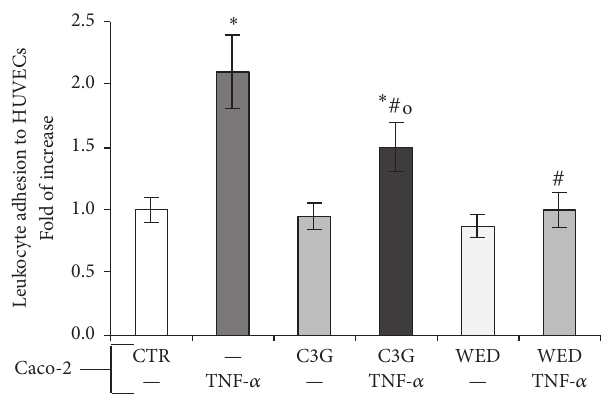
Figure 5: Leukocyte adhesion in HUVECs cocultured for 4 hours with Caco-2 cell monolayers previously pretreated for 24 hours with 20 𝜇 M C3G or with 25 𝜇 M WED for one hour and subsequently exposed to 50 ng/mL TNF- 𝛼 for one hour. Increase in leukocyte adhesion is expressed as fold of change versus the basal adhesion of leukocytes to control (HUVECs treated with Caco-2 exposed to the vehicle alone; CTR) that was set to 1. Data are reported as mean ( ± SD) of three separate experiments. ∗ 𝑝 < 0.01 versus CTR; # 𝑝 < 0.01 versus TNF- 𝛼 ; o 𝑝 < 0.01 versus